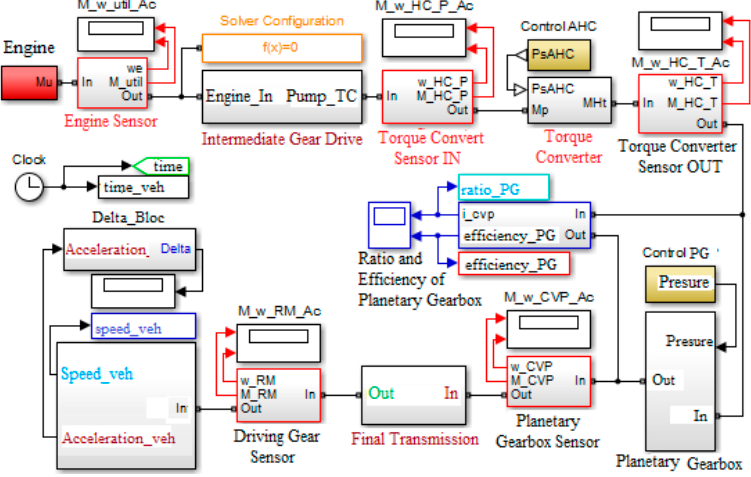
Figure 1. General virtual simulating model of the tracked vehicle [1].